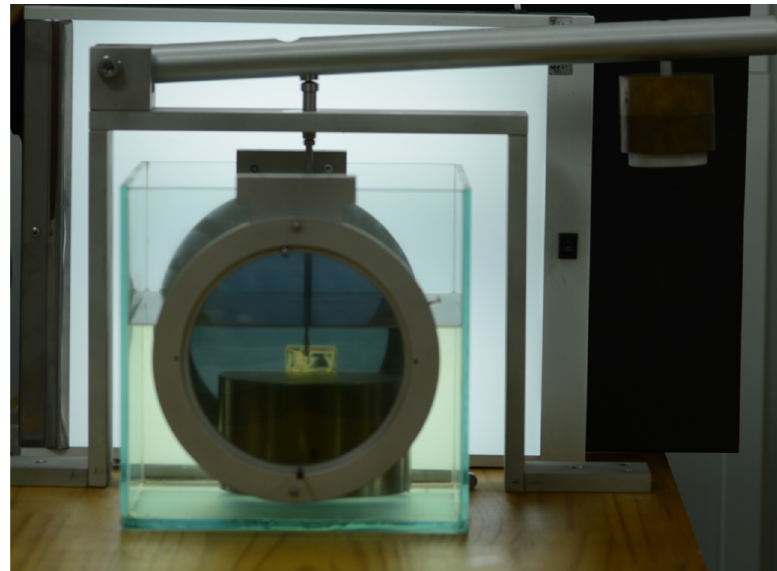
Figure 14. The specimen is in a polariscope device .